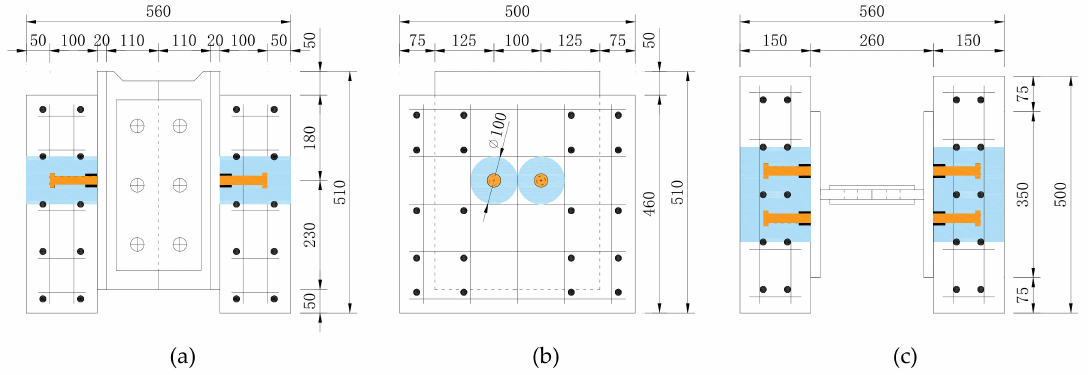
Figure 6. Details of specimens (mm): ( a ) front view; ( b ) side view; ( c ) plan view.